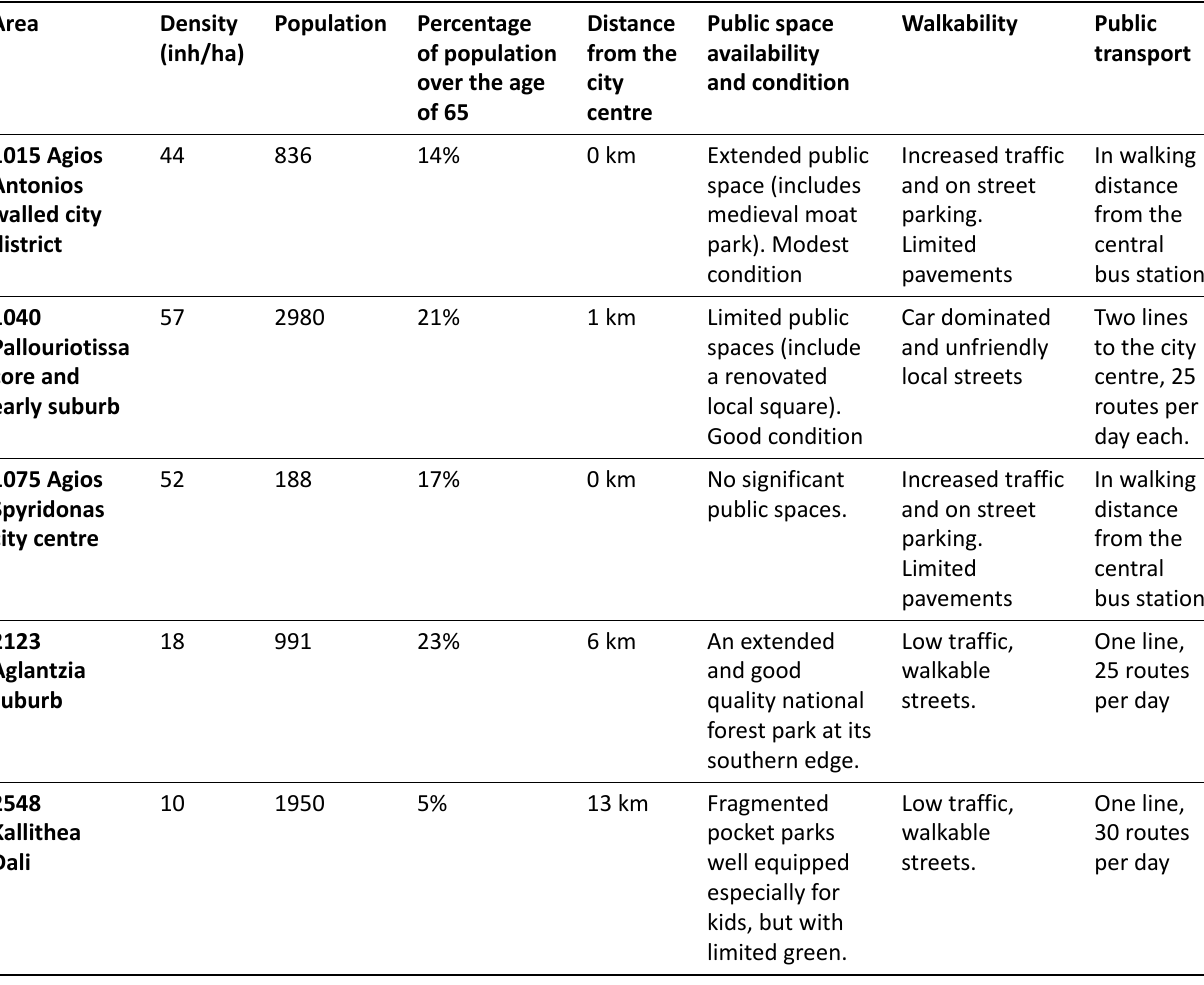
Table 1. Basic features of the selected case study areas.